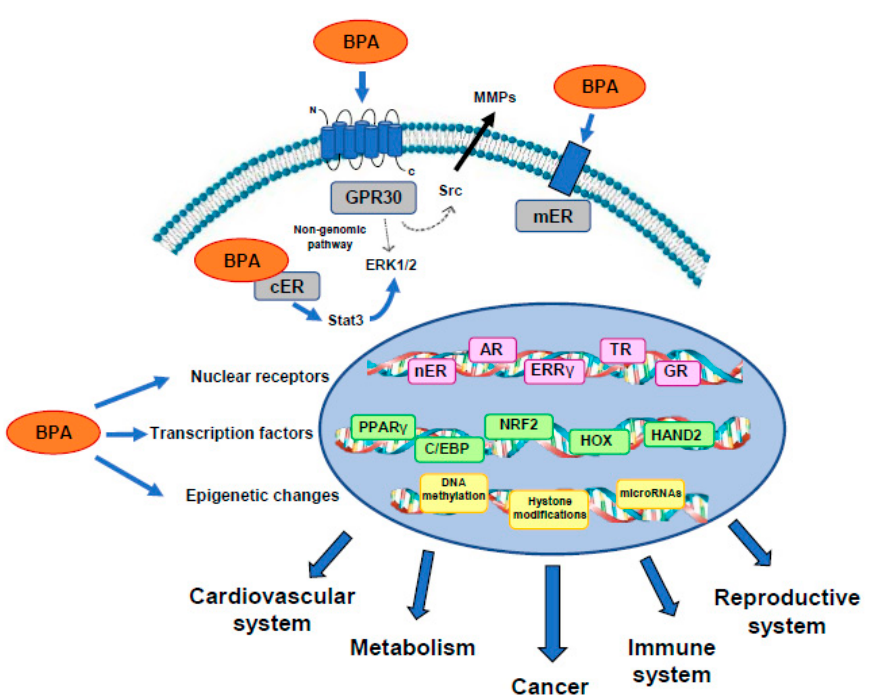
Figure 2. A potential integrative model of BPA molecular mechanisms. BPA exerts its deleterious e ff ects on the cardiovascular system, metabolism, cancer, and immune and reproductive systems, by activating specific receptors, inducing transcription factors, and through epigenetic